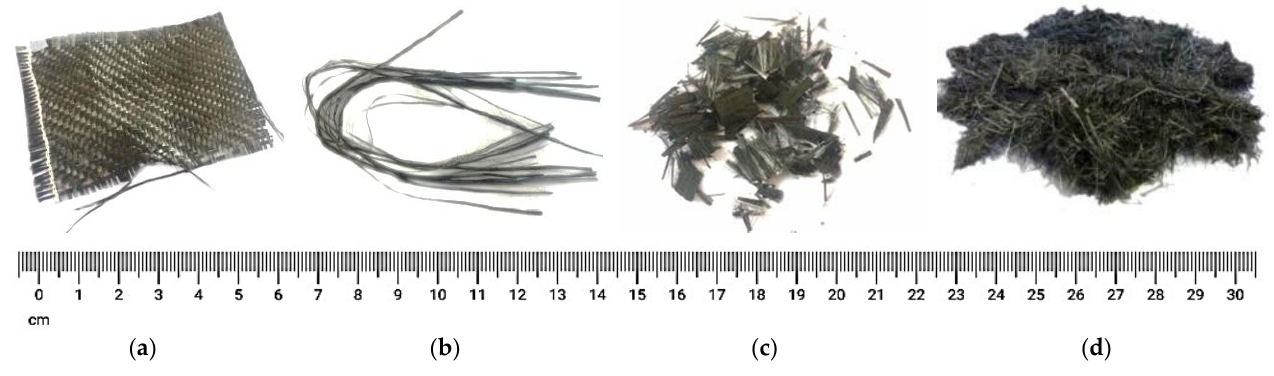
Figure 4. Types of carbon fibers: woven mat ( a ), long threaded ( b ), chopped ( c ) and finely chopped ( d ) fibers. Table 3 presents the main physical and mechanical properties of common CFs together with their characteristics and associated applications. Table 3. Physical/mechanical properties and main applications of carbon fibers according to precursor material